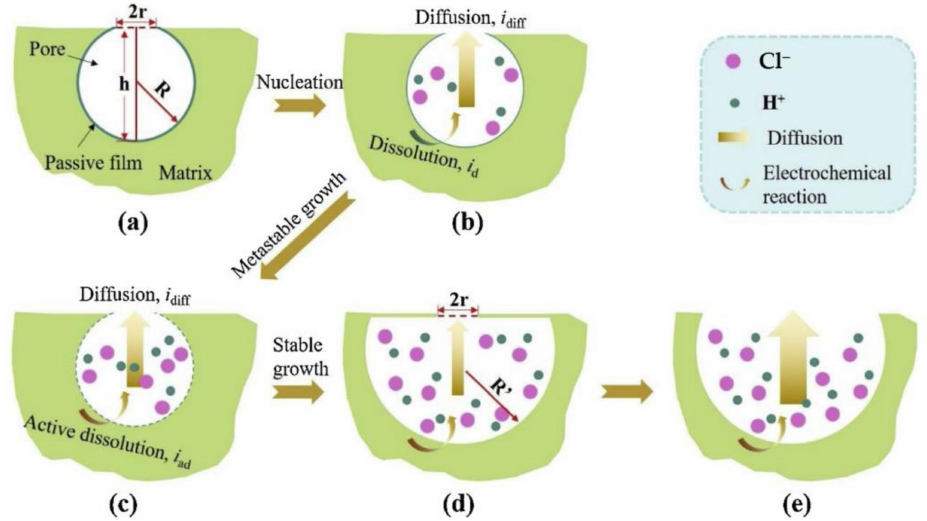
Figure 11. The pitting mechanisms associated with SLM’ed 316L SS through the surface gas pores with ( a ) the initial formation of the passive film, to the transition of ( b ) pit nucleation and ( c ) pit diffusion, to the ( d ) stable growth the metastable pit and the ( e ) material degradation from the active state dissolution process [106] Copyright 2022